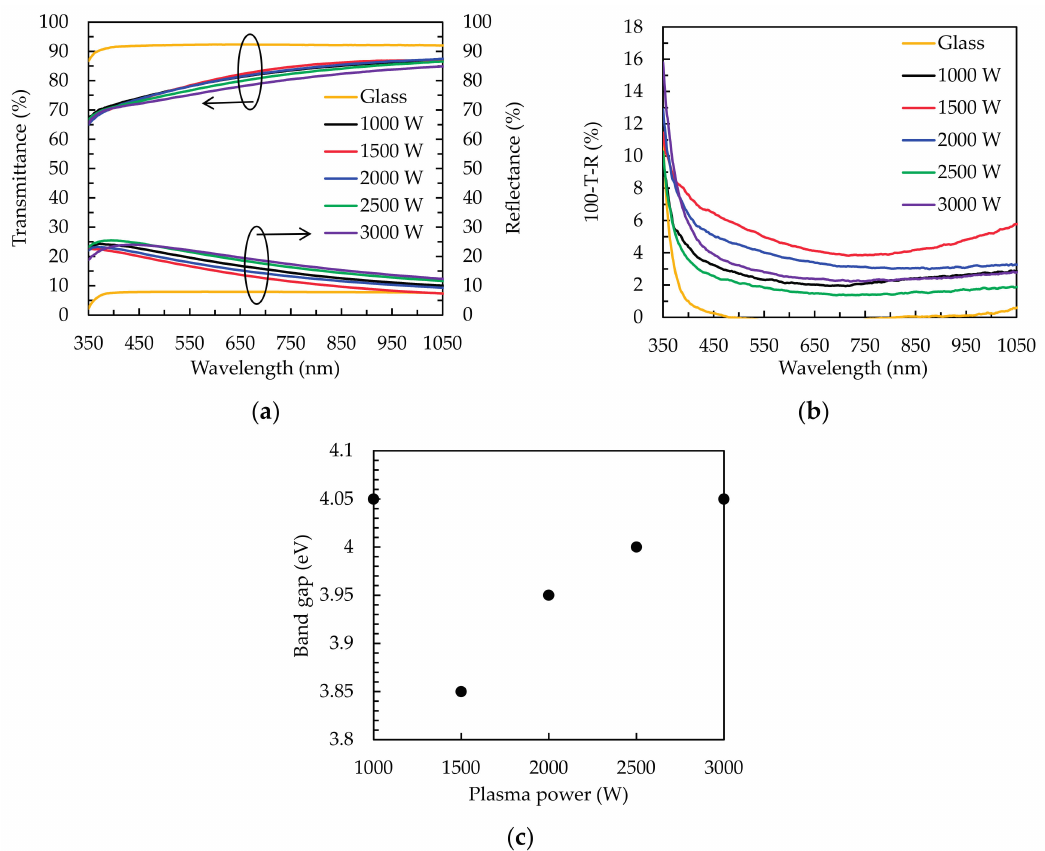
Figure 7. ( a ) Transmittance and reflectance spectra, ( b ) optical loss spectra, and ( c ) band gap (Eg) of the PEALD SnO 2 thin films obtained by different plasma